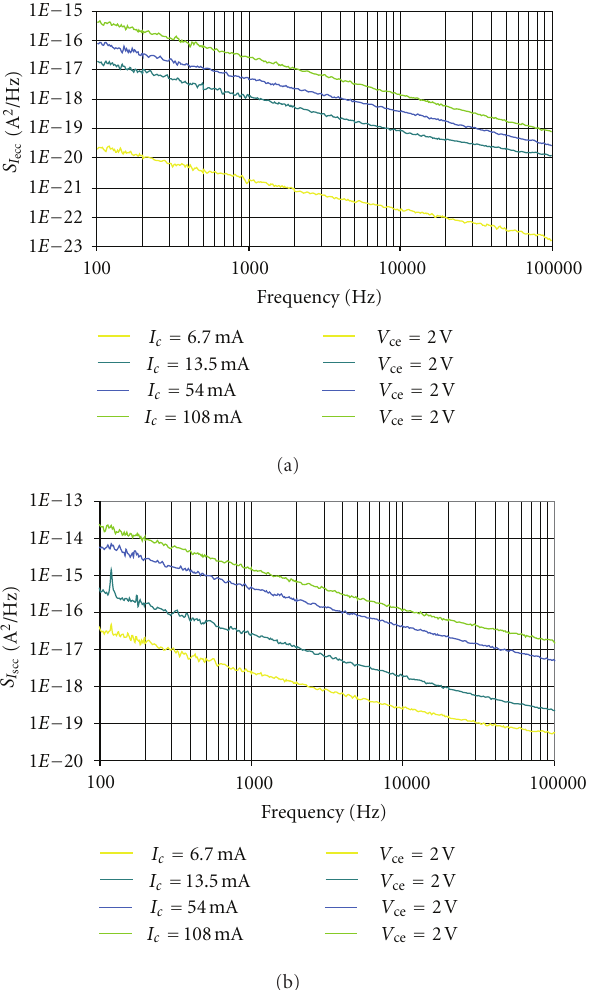
Figure 10: Plot of S ic and SI nc noise current spectral = 6 . 7,13 . 5,54,108mA. 0